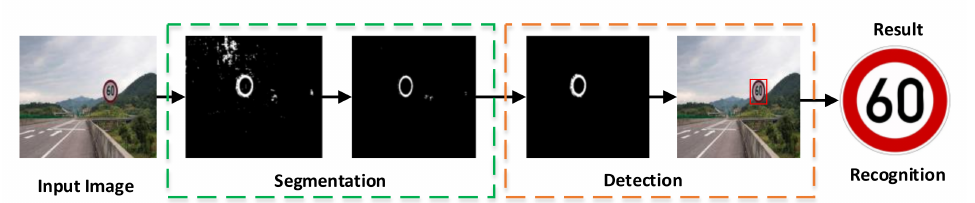
Figure 9. Overview of the approach proposed by Gudigar et